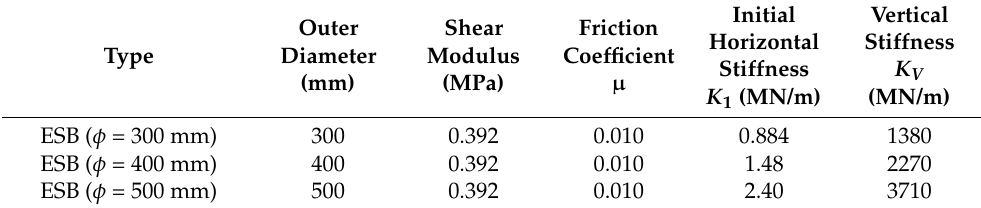
Table 3. Properties of the selected elastic sliding bearings (ESBs).